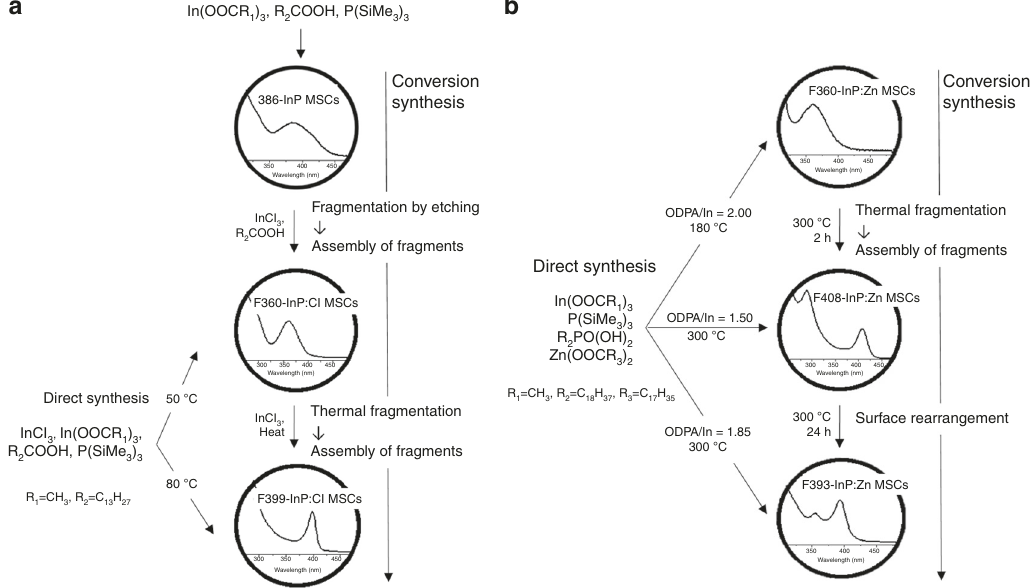
Fig. 1 Schematic illustration. Direct or conversion synthesis pathway for a Cl-incorporated InP MSCs and b Zn-incorporated InP